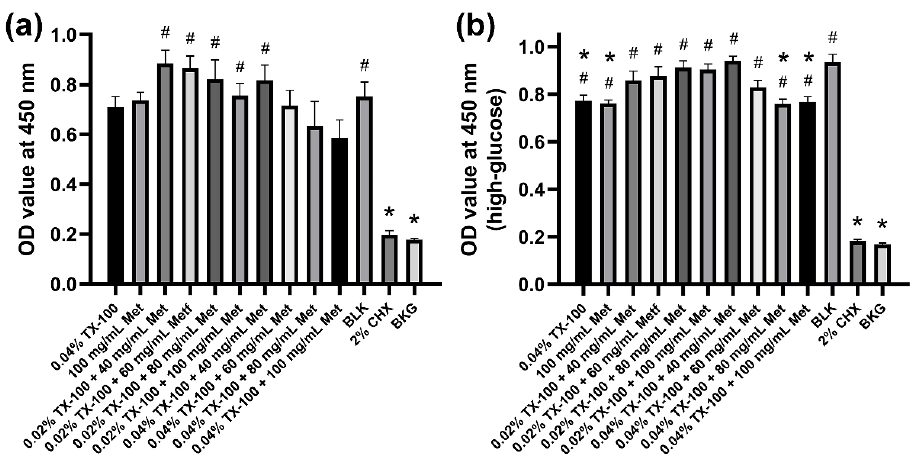
Figure 7. CCK-8 test on osteoblastic MC3T3-E1 cells. ( a ) in normal DMEM; ( b ) in high-glucose DMEM. (*: significant difference compared with the blank control group; #: significant difference compared with the 2% CHX group; p < 0.05).